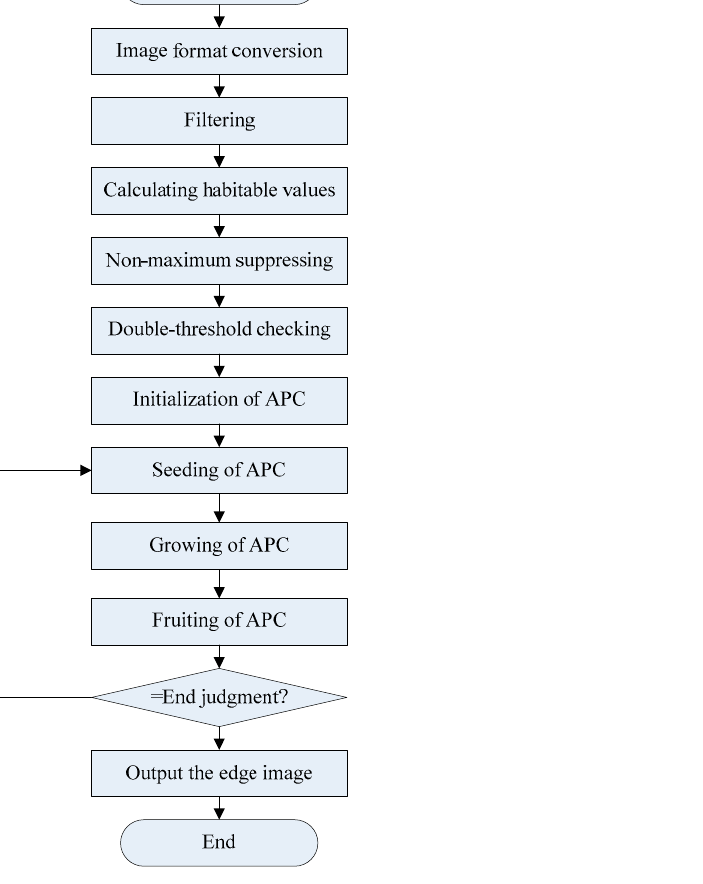
Figure 2. The APC algorithm for image edge detection.